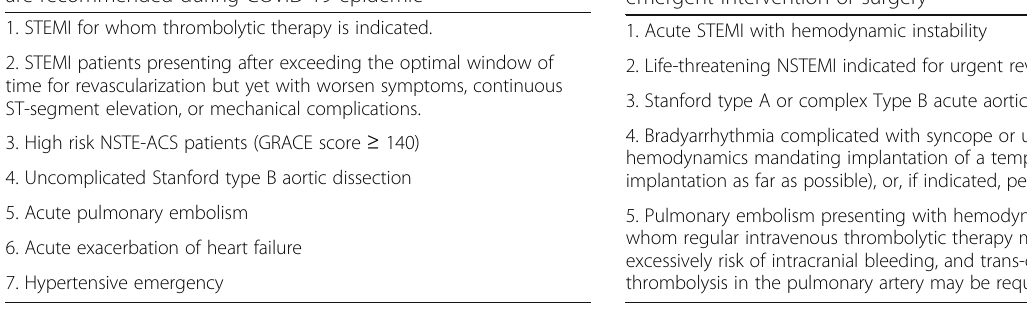
Table 3 Patients with severe emergent cardiovascular diseases for whom hospitalization and conservative medical treatment are recommended during COVID-19 epidemic